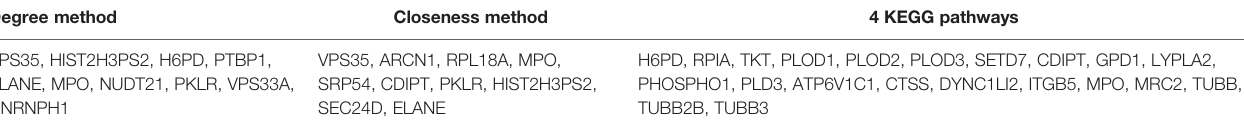
TABLE 3 | DEPs in the KEGG pathways, Degree method, and Closeness